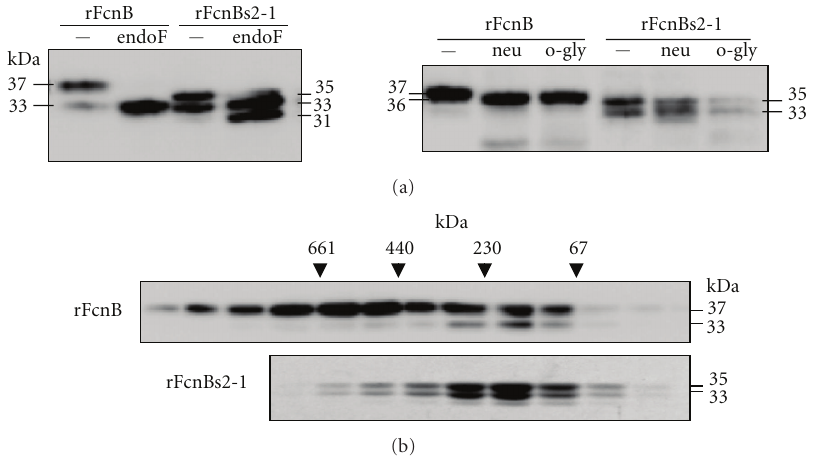
Figure 3: Structural characterization of rFcnB. (a) Left panel: Western blot of rFcnB and rFcnBs2-1 treated with endoglycosidase F (endoF). Right panel: western blot of rFcnB and rFcnBs2-1 treated with neuraminidase (neu) or neuraminidase plus endo- α - N - acetylgalactosaminidase ( o -gly). Western blotting was performed under reducing conditions. —, not treated. (b) Gel chromatography of rFcnB (upper panel) and rFcnBs2-1 (lower panel). rFcnB or rFcnBs2-1 (400 μ L; 5–10 μ g) was applied to a Superose 6 column (1cm φ × 30cm) and fractionated into 0.5 mL/fractions. An aliquot of each fraction was subjected to western blotting for FcnB under reducing